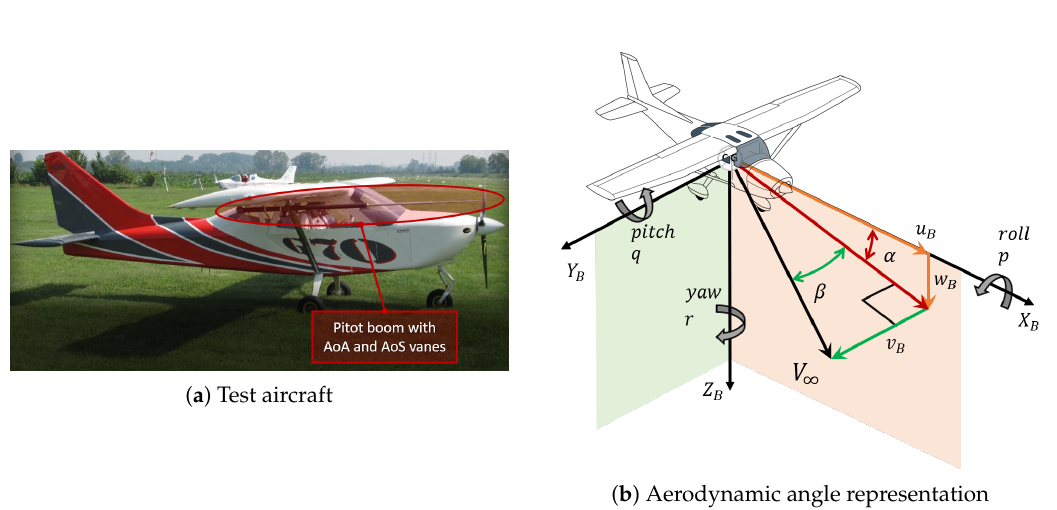
Figure 2. Reference aircraft and